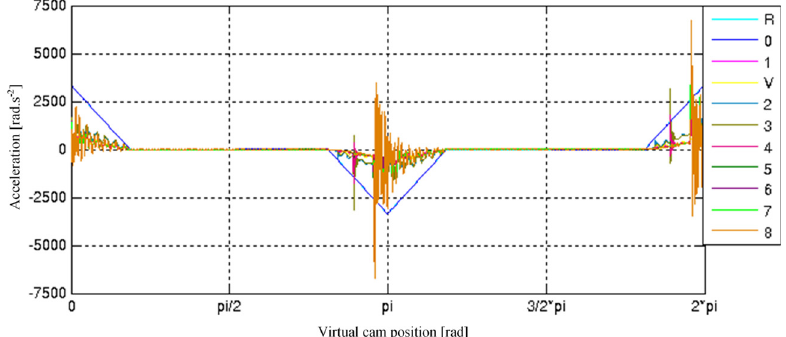
Figure 8. Courses of angular accelerations of individual drive system elements.